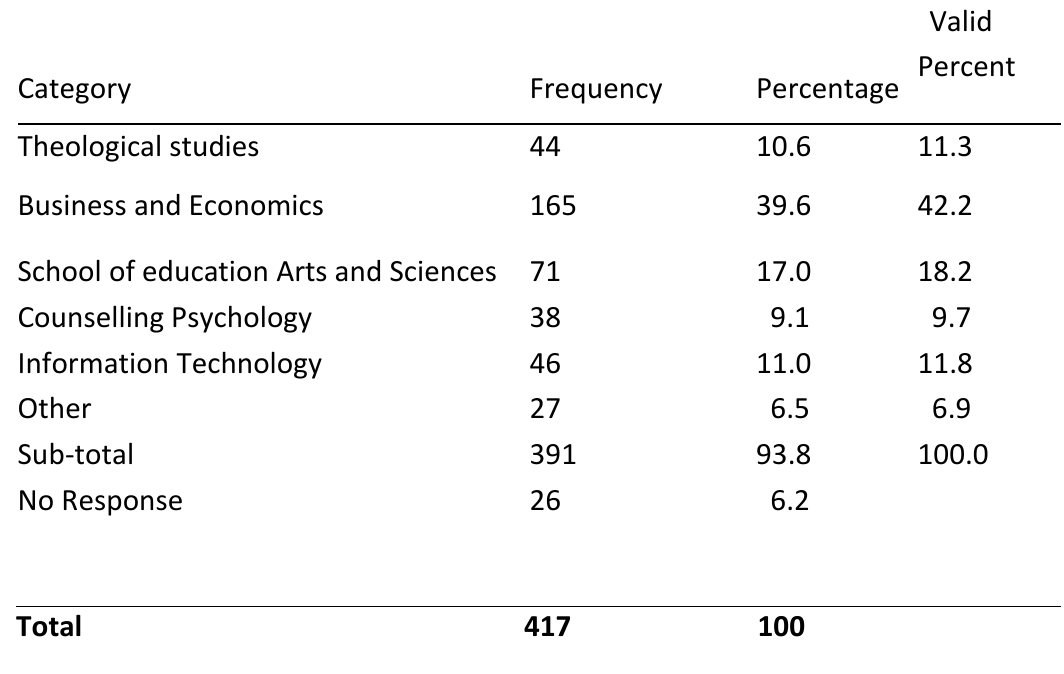
Table 2. Students' area of